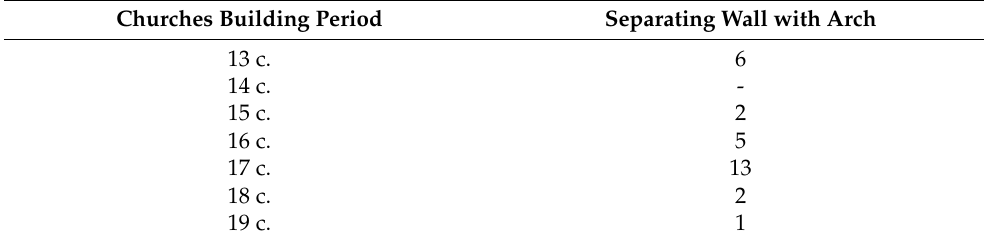
Table 2. The number of churches during construction periods with a separating wall between the altar and the